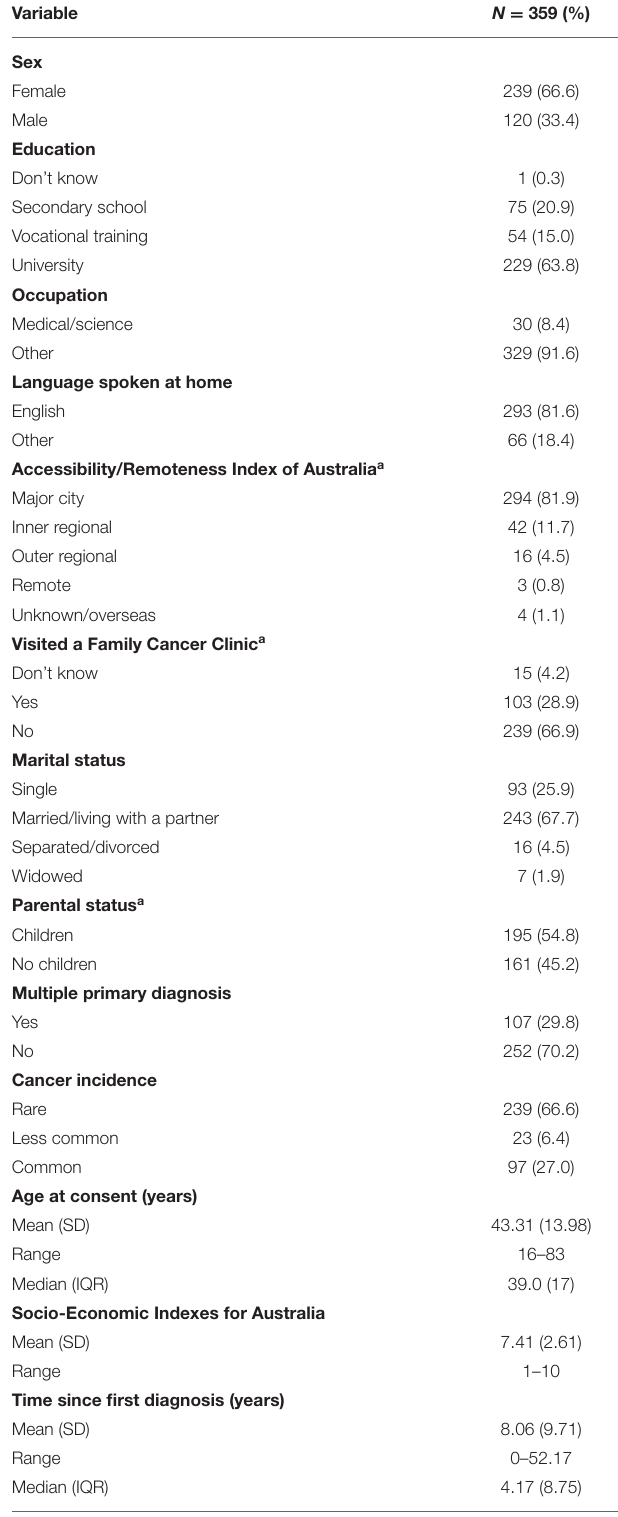
TABLE 2 | Demographic and disease characteristics of the PiGeOn study